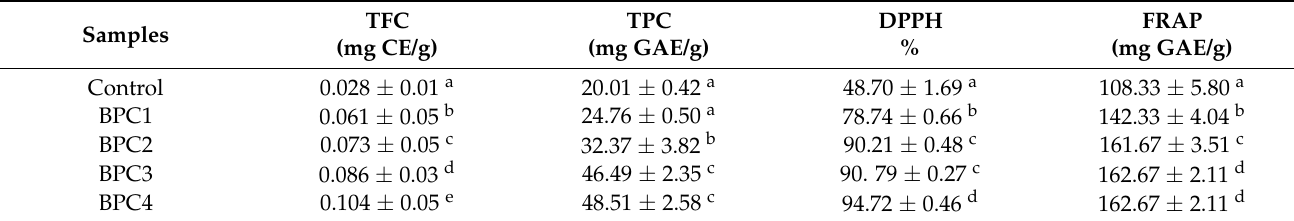
Table 5. Polyphenolic compounds and antioxidant activity of the composite biscuits.